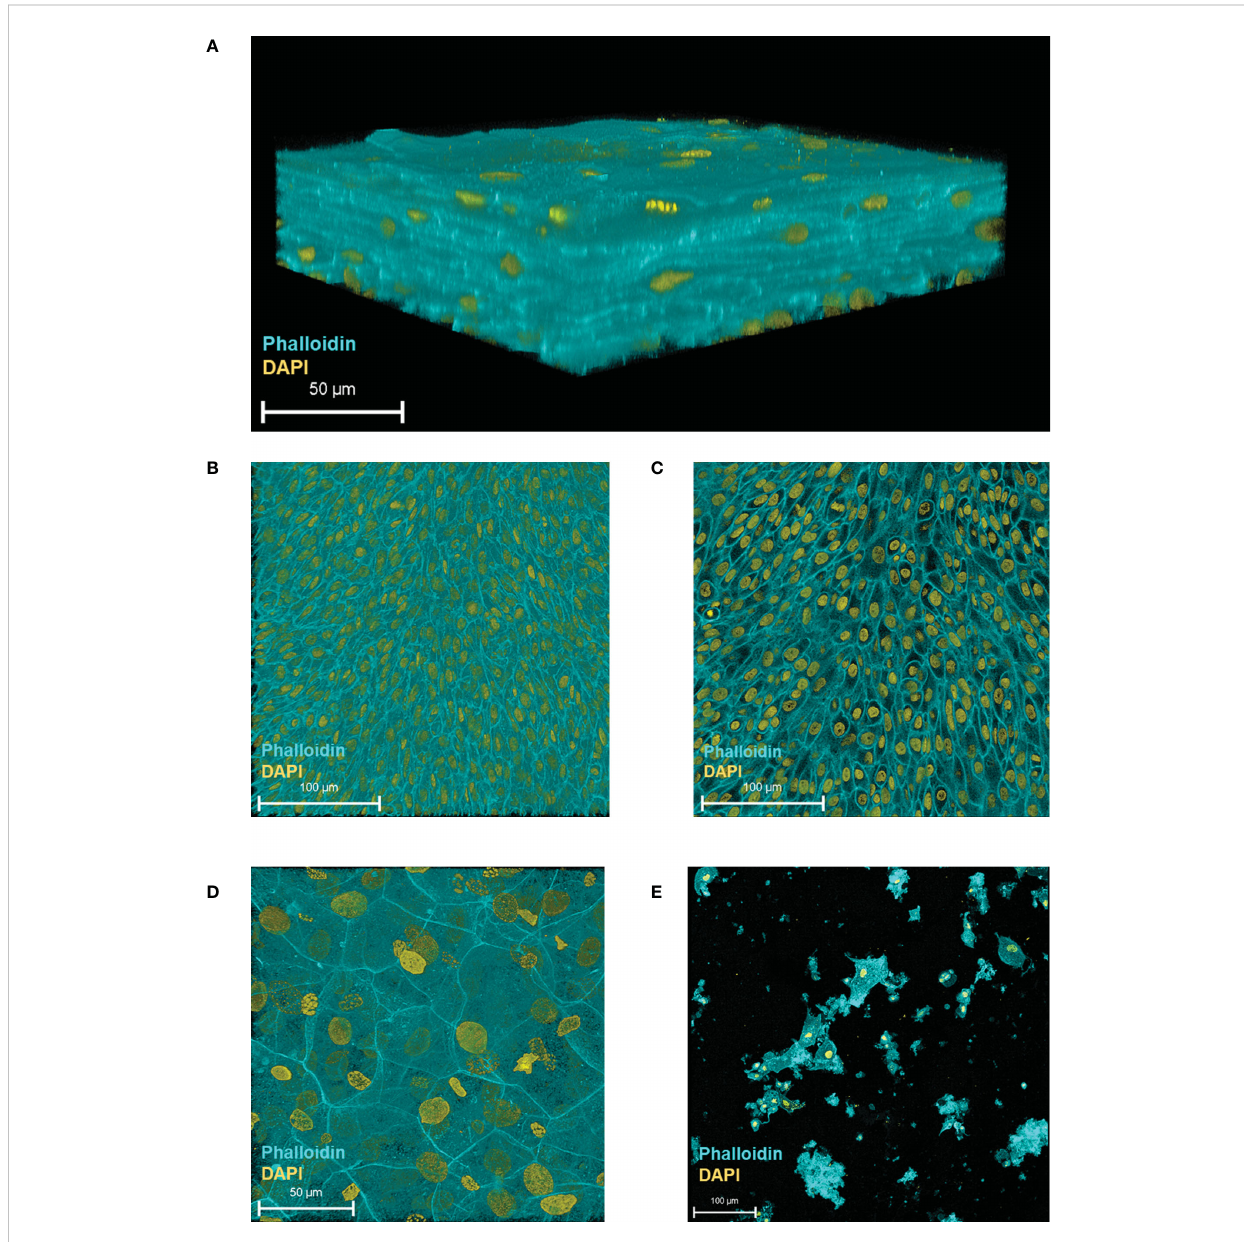
FIGURE 1 HBLAK cells differentiate, stratify and form a 3D urothelial microtissue model, 3D-UHU in 100% urine. (A) 3D confocal image of the urothelial model; (B) single optical slice at the lowest region of the model showing small, tightly packed basal cells; (C) single optical slice at the mid-section presenting slightly larger intermediate cells; (D) single optical slice at the apical surface exhibiting large, differentiated umbrella-like cells; (E) shed cells detected at day 18 in fully differentiated 3D models (supernatants collected from 12 models). Phalloidin-stained F-actin is presented in cyan